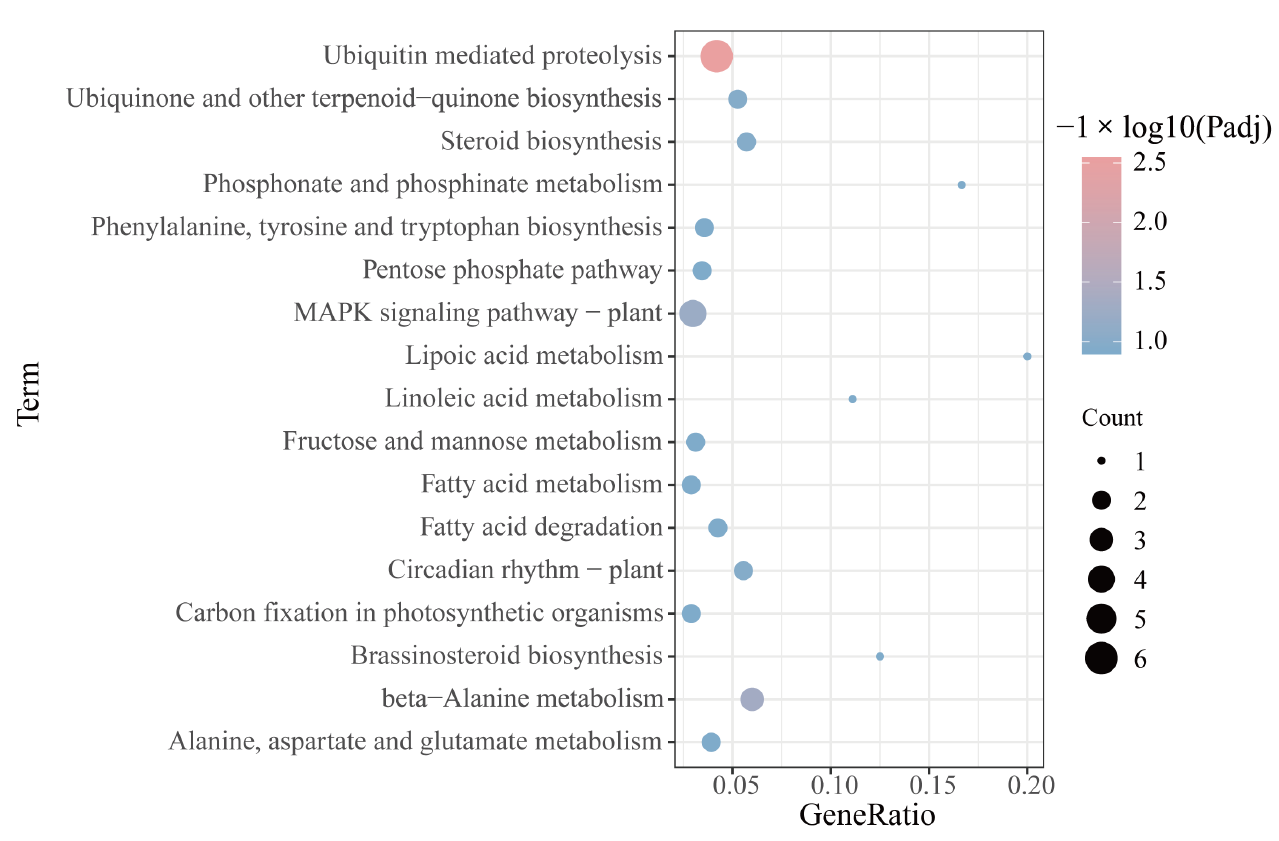
Figure 6. KEGG pathway analysis of mRNA. Only the terms with p - value ≤ 0.05 are shown.